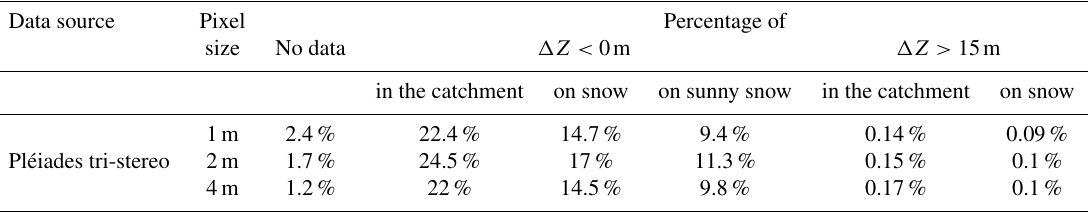
Table 3. Percentage of potential outliers and no data in the dDEM values, considering the catchment area, the snow-covered area of the catchment, and the snow-covered area of the catchment located out of the shadows due to the high cliffs (here indicated as “sunny